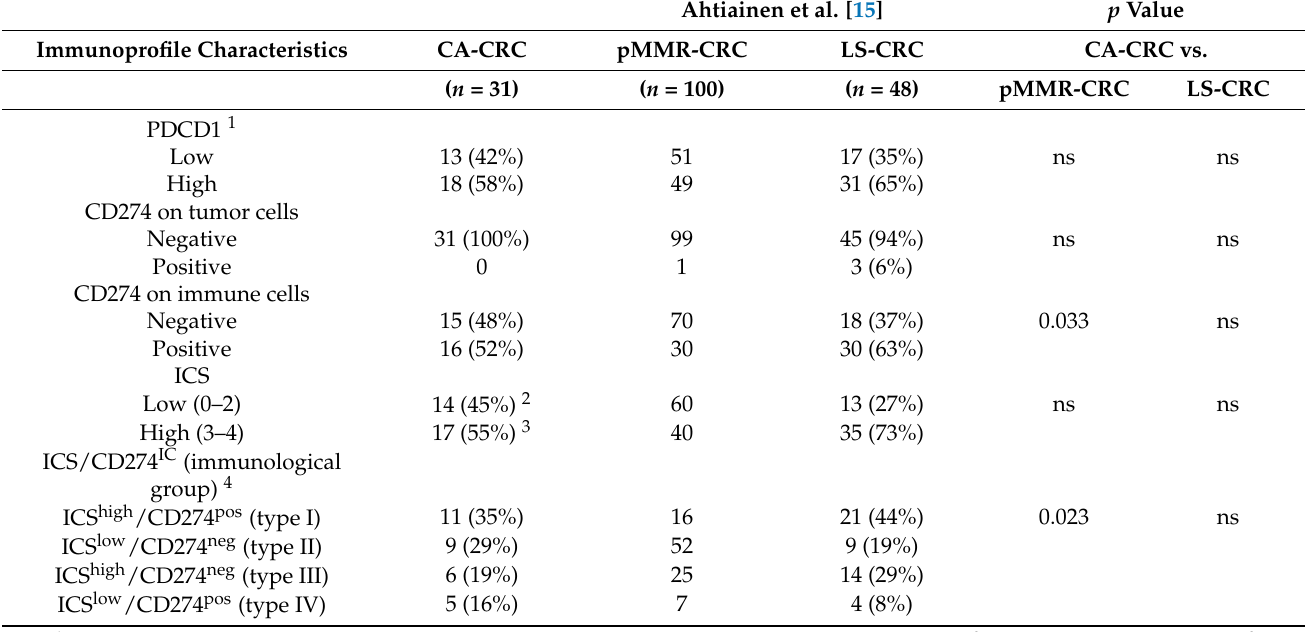
Table 2. PDCD1, CD274, and ICSs in CA-CRC (this study), compared with sporadic pMMR-CRC and LS-CRC from our previous